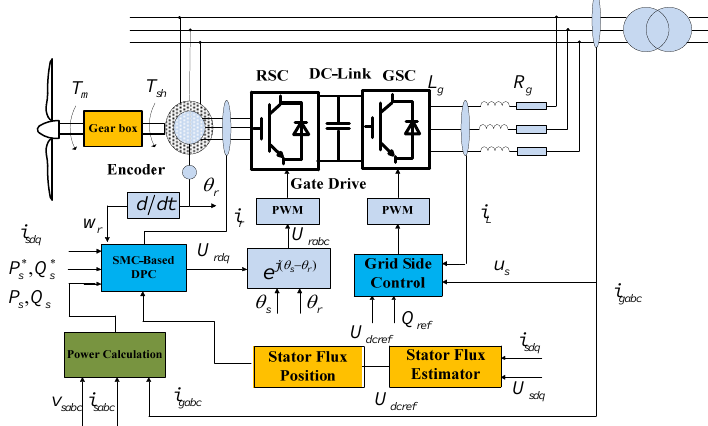
Figure 5. Control diagram of DFIG-based wind energy conversion system (WECS) with the sliding mode control (SMC) ‐ based direct power control (DPC) approach.